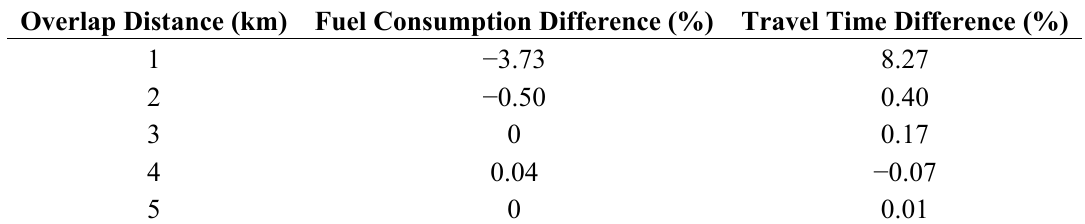
Table 2. Differences between the optimal speed profile and the approximate speed profile using